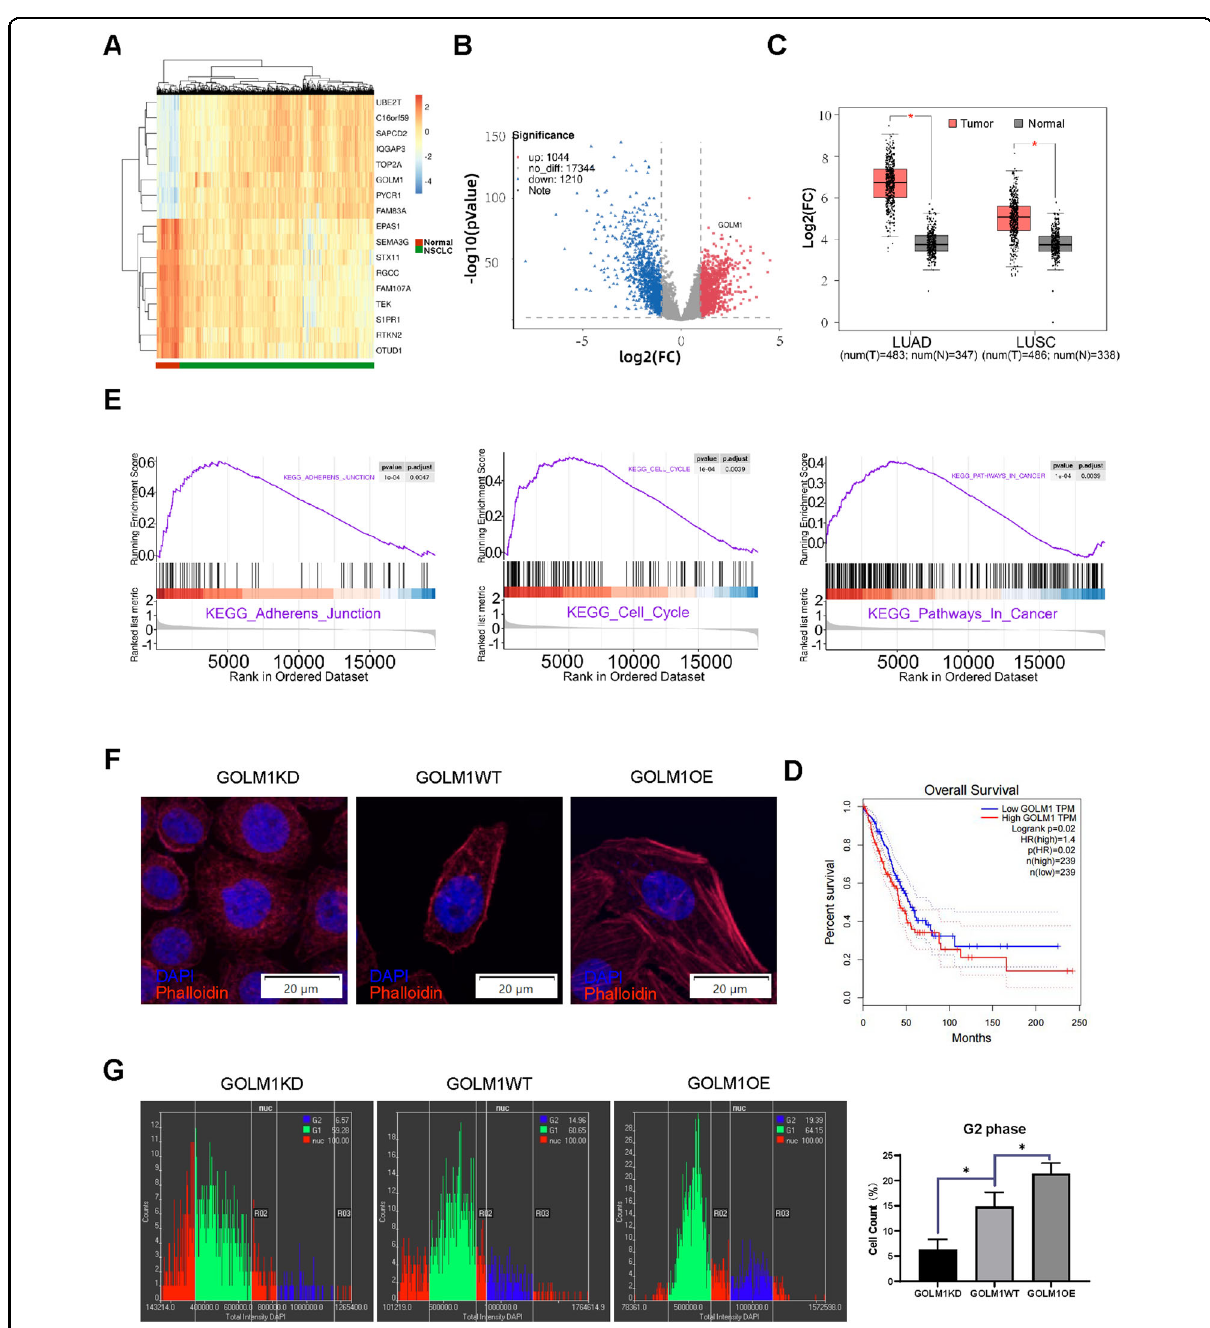
Fig. 1 GOLM1 is highly expressed in patients with non-small cell lung cancer whose expression level is negatively correlated with patients ’ OS. A Heatmap of expression levels of suspect candidate differentially expressed genes (DEGs) in NSCLC patients from TCGA dataset. B The DEGs volcano map in TCGA dataset (GOLM1 was marked). C Expression levels of GOLM1 in lung adenocarcinoma (LUAD) and squamous cell lung carcinoma (LUSC) from TCGA dataset. Pink refers to tumor group, Grey refers to normal group. (Data were means ± SEM. * P < 0.05). D Overall survival (OS) of the lung adenocarcinoma patients with GOLM1 high expressing level against low expressing level. E Single gene GSEA analysis of KEGG reference gene sets for GOLM1 high expression groups against low expression groups from TCGA dataset. F Actin polymerization was assessed through immuno fl uorescence assays. Red fl uorescence represents Phalloidin, and blue (DAPI) represents cell nucleus. G The cell-cycle assay through high content screening (HCS) system and the statistical analysis of cell count (%) in G2 phase among GOLM1KD, GOLM1WT, and GOLM1OE group. GOLM1KD = GOLM1 knockdown group, GOLM1WT = wild-type group, GOLM1OE = GOLM1 overexpression group. Data were means ± SEM. * P < 0.05, n =